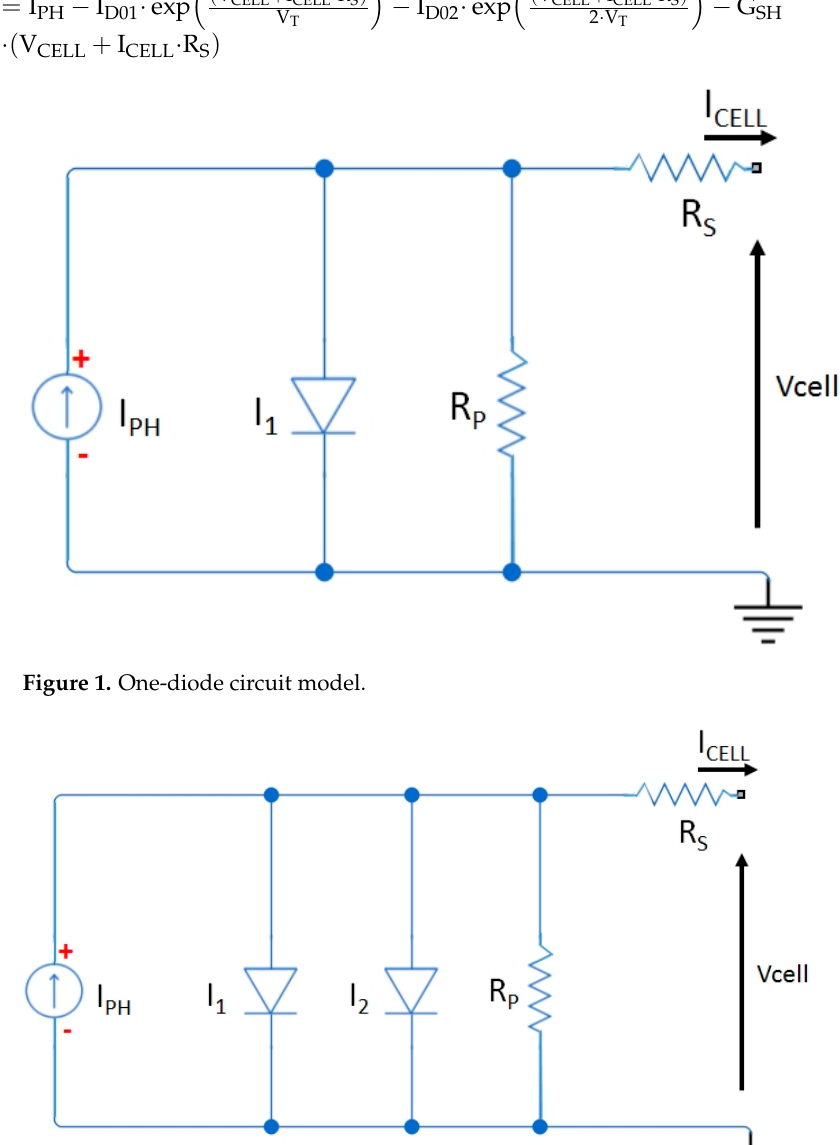
Figure 2. Two-diode circuit